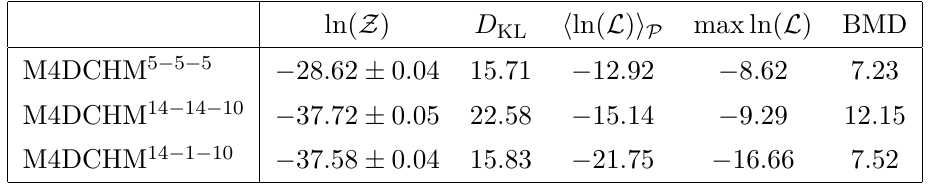
Table 5. Statistics from the combined Bayesian scans of each model, using the imposed